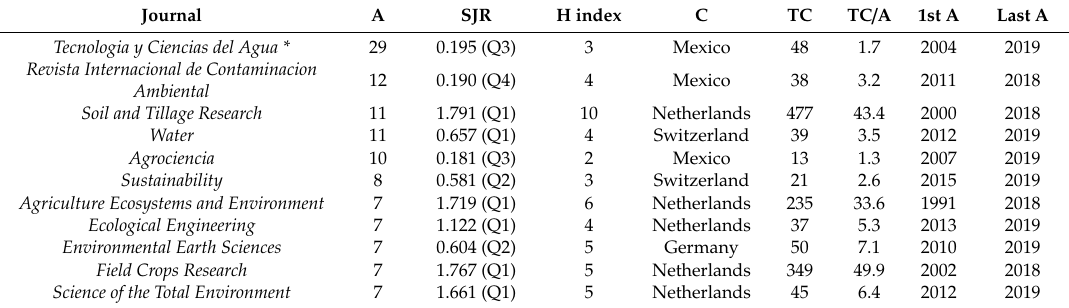
Table 4. Major characteristics of the most active journals related to sustainable agricultural water management in Mexico (SAWMM)